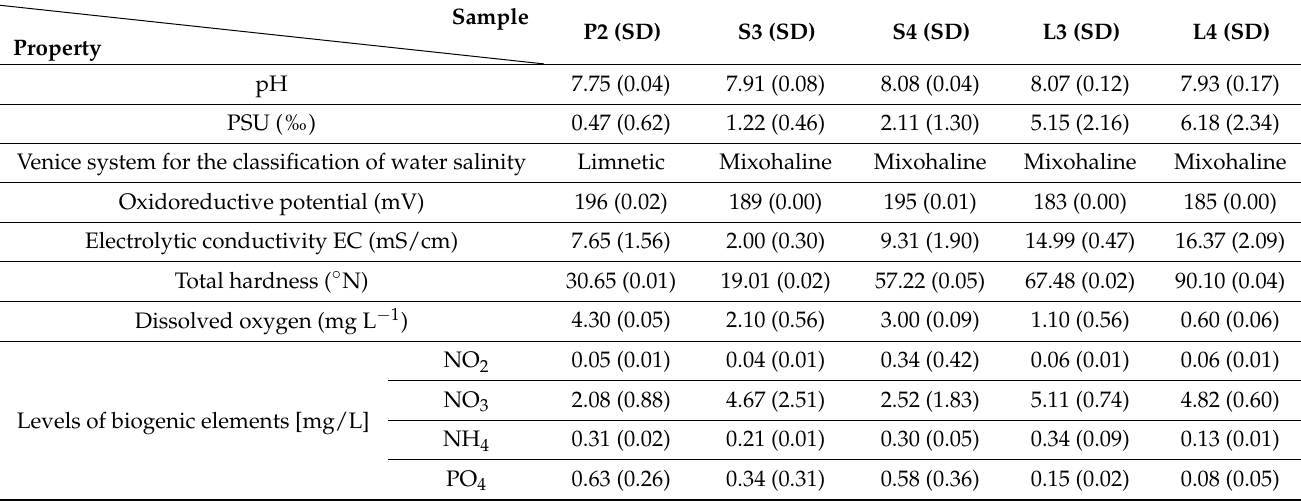
Table 2. Physical and chemical properties of winter control and ship ballast water samples.